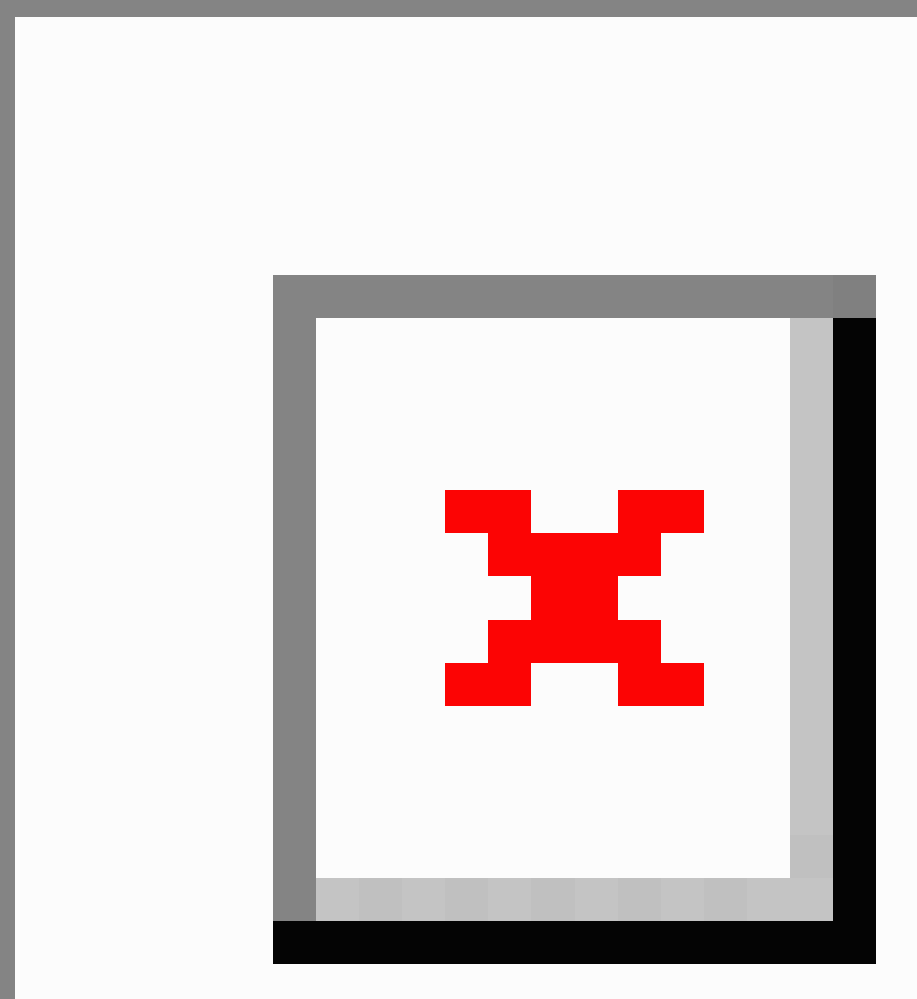
Figure 1. Screenshot of e-couch cognitive behavior therapy (CBT)